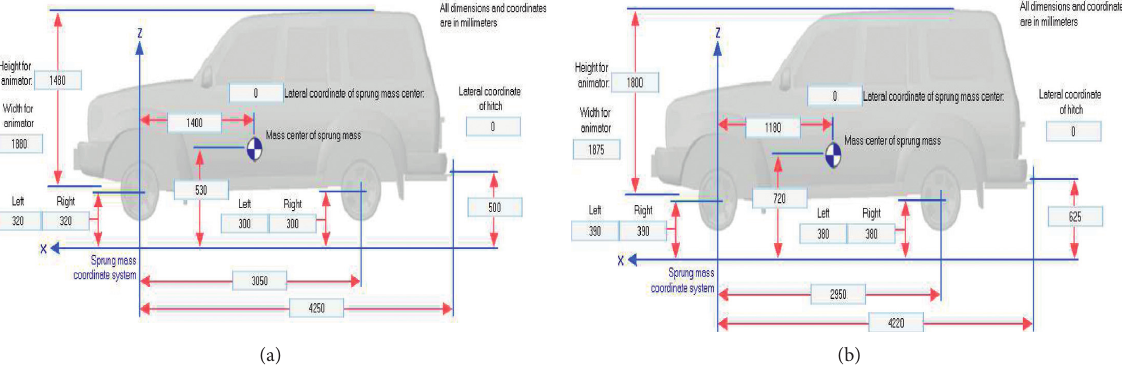
Figure 2: Vehicle properties. (a) Sedan. (b) SUV.